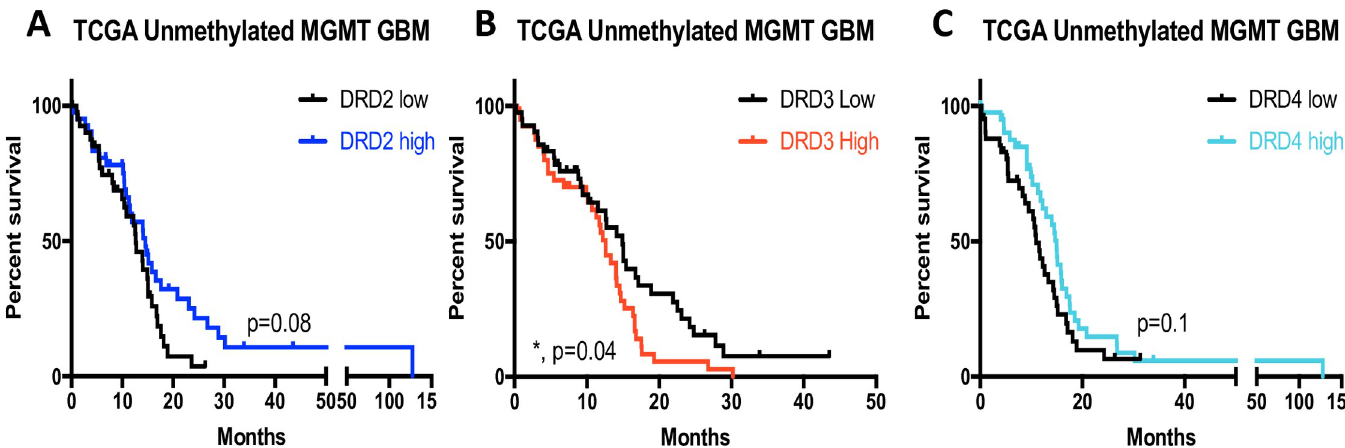
Fig 3. DRD3 correlates with worse prognosis in MGMT unmethylated GBMs. Survival of patients with primary, unmethylated MGMT GBMs segregated by (A) DRD2, (B) DRD3, or (C) DRD4 mRNA levels (highest or lowest 25%, n = 42). p values for Log-rank analysis are shown, data downloaded from GlioVis (http://gliovis.bioinfo.